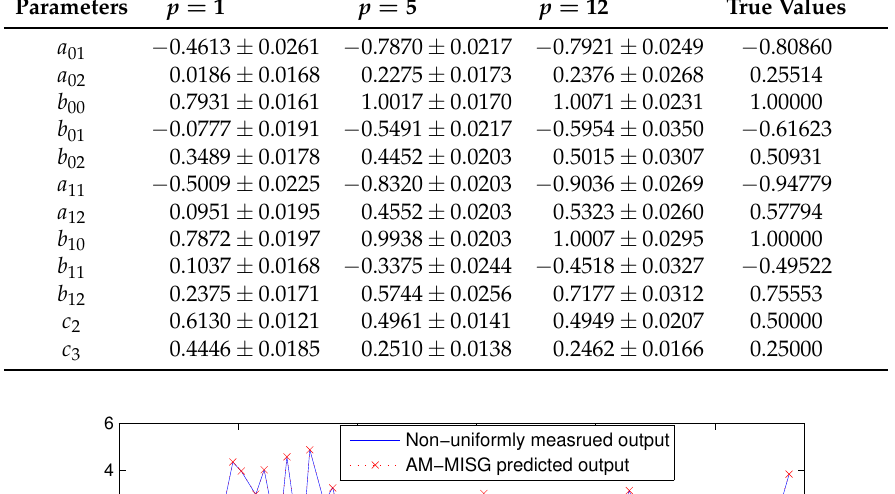
Table 5. The AM-MISG parameter estimates with standard deviations ( σ 2 = 0.50 2 ).